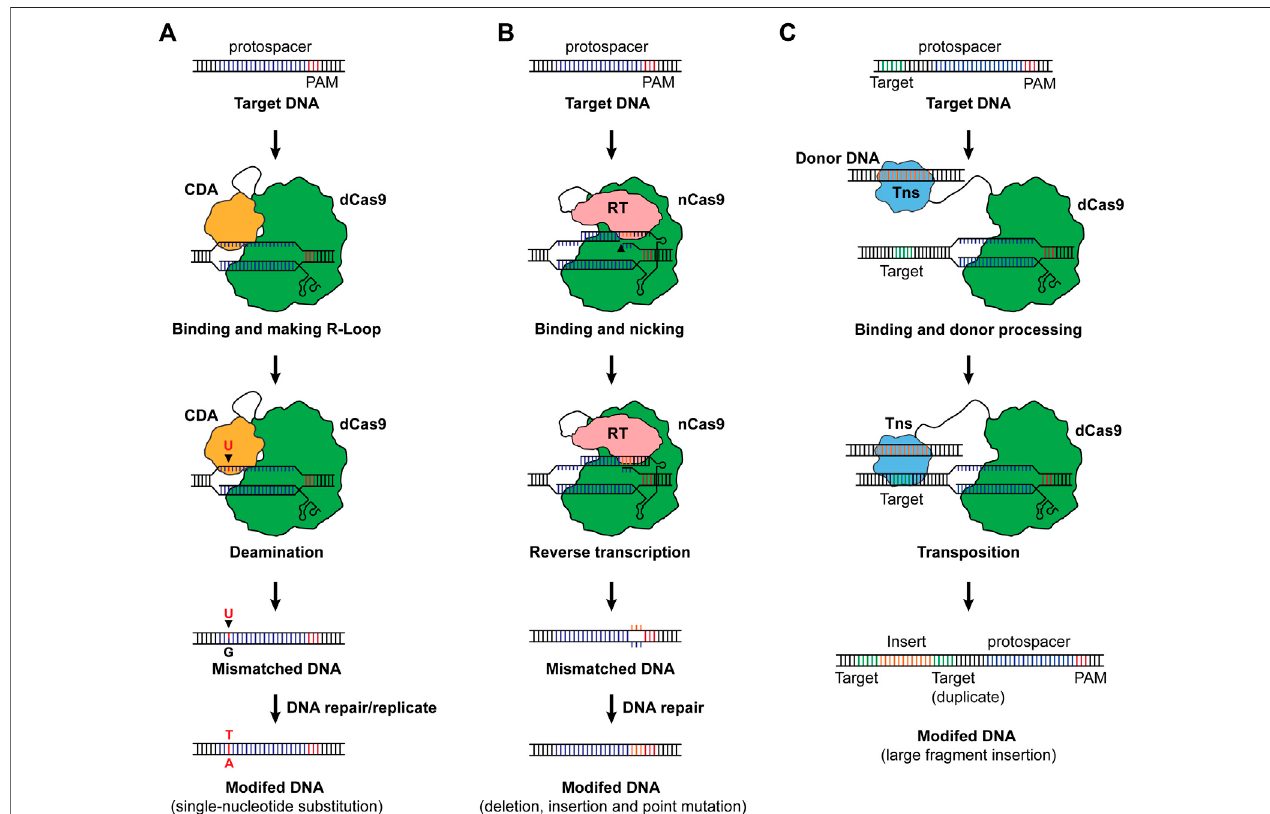
FIGURE 2 | (A) Base editing. The cytosine base editor with a combination of dCas9 cytosine deaminase is shown as an example to illustrate the working mechanism. When dCas9 binds to its target sequence and an R-loop is formed, the cytosine deaminase (CDA) mutates a cytosine (C) to uracil (U), generating a uracil- guanine (U – G) mismatch. The C will then be replaced by thymine (T) along with the reparation of the mismatch upon DNA repair or replication, resulting in a C-to-T substitution at aone-nucleotide resolution. For adenine base editors, an A-to-G substitutionwill occur asa result of base editing. Notably, nCas9 can also be used astheeffectorforbaseeditors. (B) Primeediting.TheprimeeditingtakesadvantageofnCas9andafusedreverse-transcription(RT).BydesigningapegRNAconsisting of the spacer for targeting, RT template with designed edits, and primer binding site (PBS), deletions, insertions and point mutations can be achieved. (C) Transposon- mediatedCRISPR-Cas systemforDNAintegration.Asaparadigm,dCas9wasfusedtoatransposase(Tns),andwhenthetransposasewasledtothetargetsequence, it recognizes the motif for transposition and integrates the donor DNA into the upstream of the protospacer, enabling large fragment insertions. Cas9 was used as the Cas effector for illustration of the basic working principles of base editing, prime editing and transposon-mediated editing.